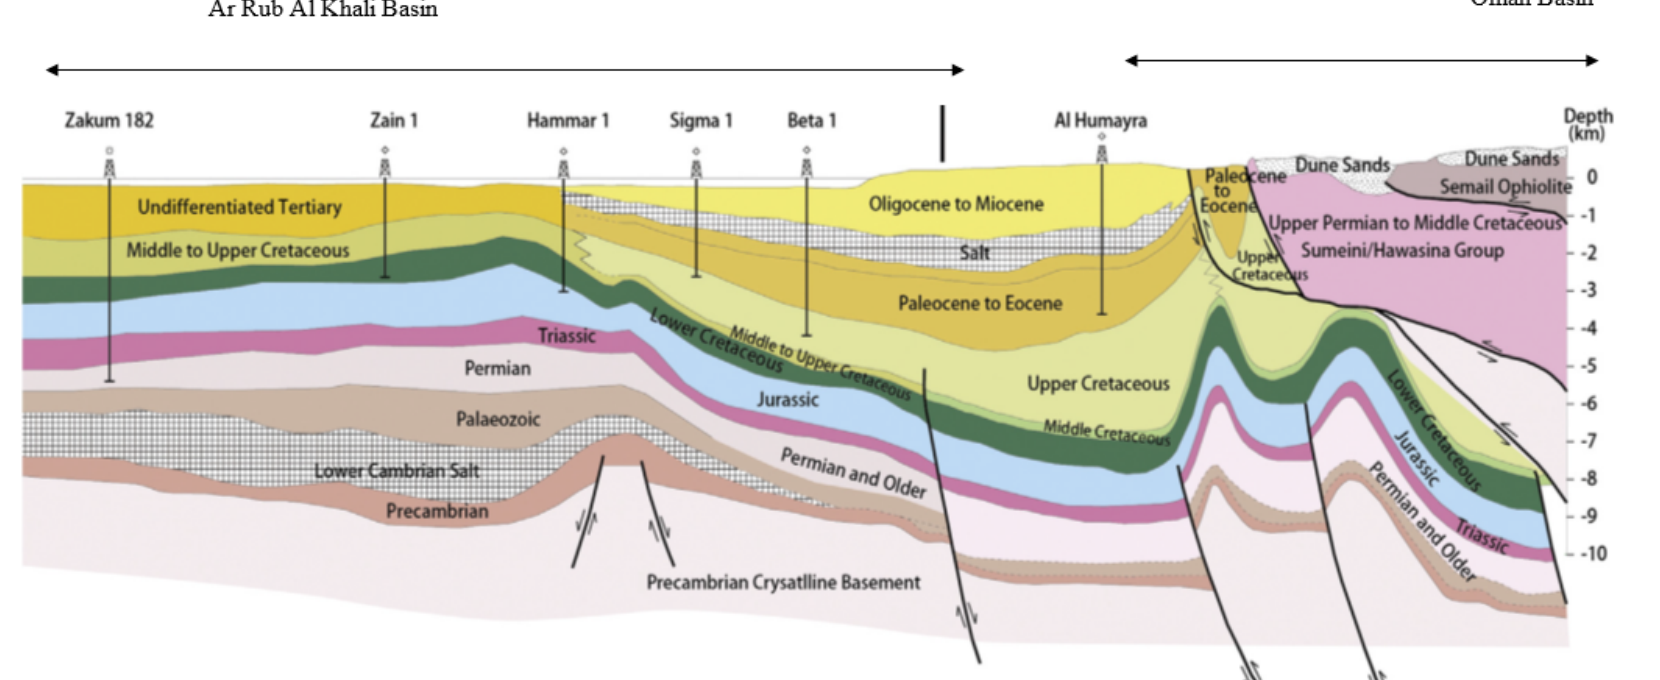
Figure 3. E–W regional geological cross-section across the ARAK region constructed from oil wells showing how the Oman Mountain and sedimentary groups formed and deformed, including the hydrological aquifers in the study area [2,3].